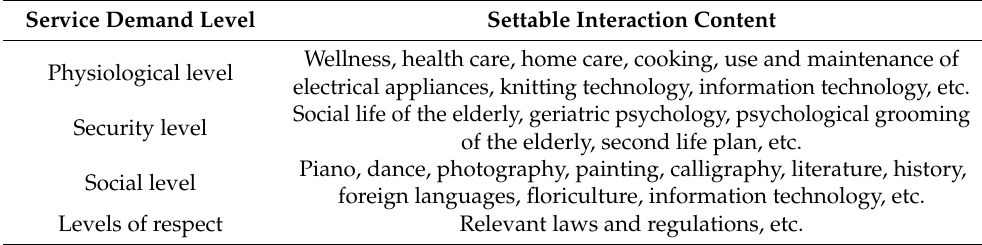
Table 2. Relationship between service demand and Interaction content.